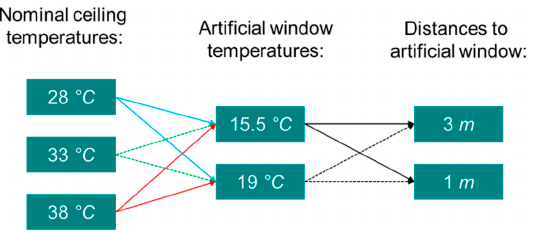
Figure 2. Experimental scenarios: a combination of three ceiling temperatures, two artificial window temperatures, and two distances to the artificial window. The scenarios are discussed in Section 2.3.